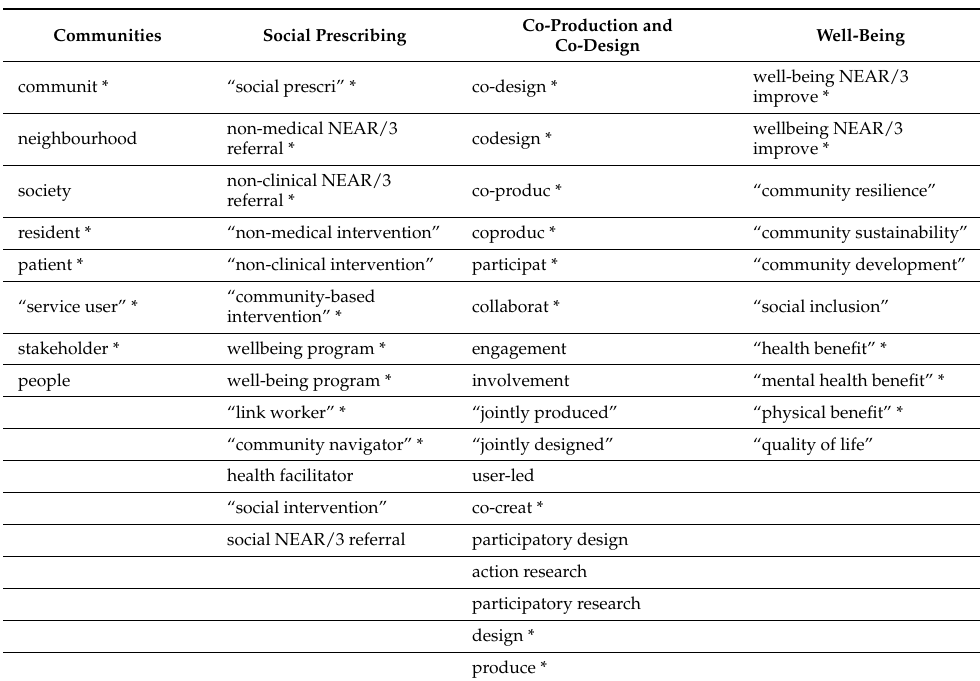
Table A2. Search terms for mixed methods search strategy.